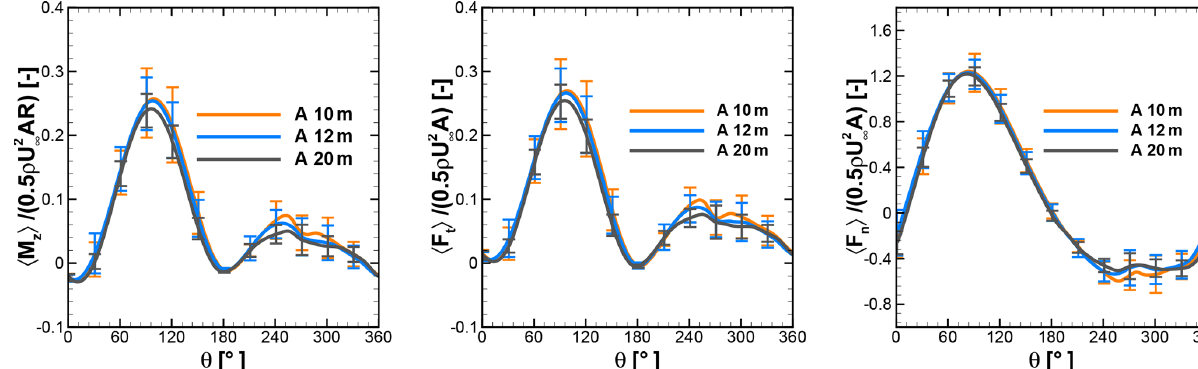
Figure 15. Normalized moment and tangential and normal forces of a single blade at λ = 2 . 75 under turbulent inflow at rooftop of A.